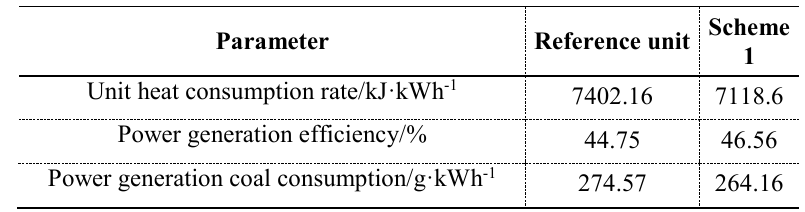
Table 1. Performance analysis of reference unit and scheme